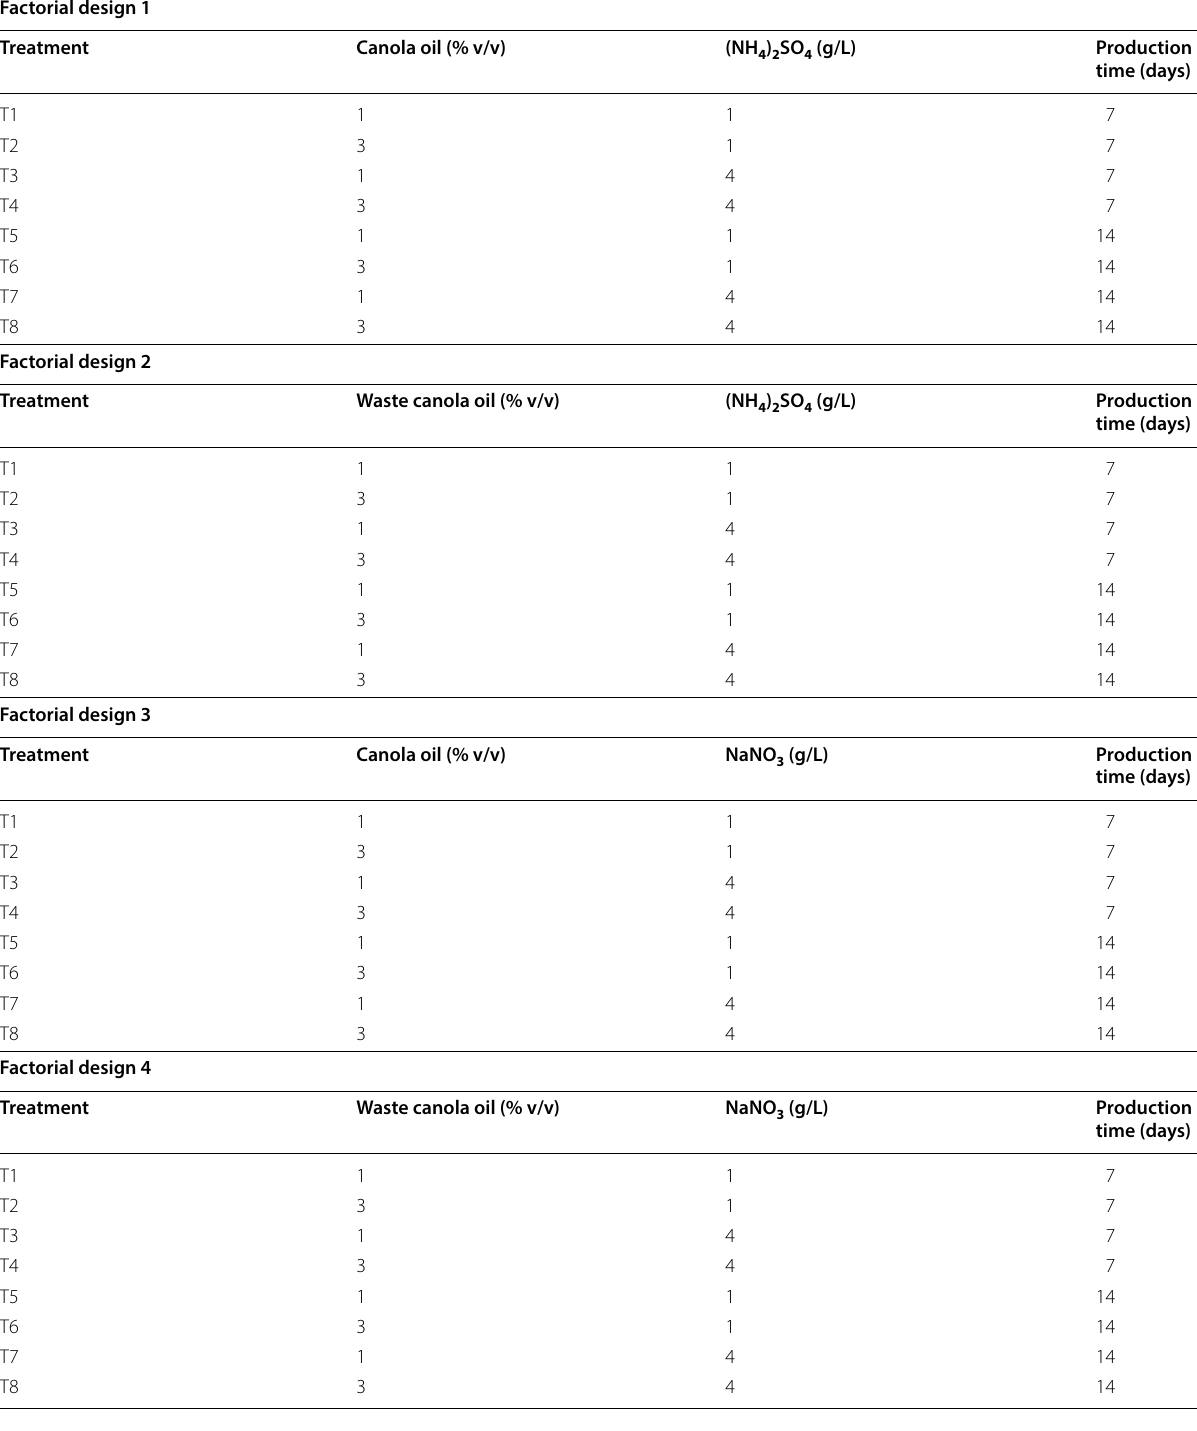
Table 2 2 3 full factorial designs used to optimize rhamnolipid production Factorial design